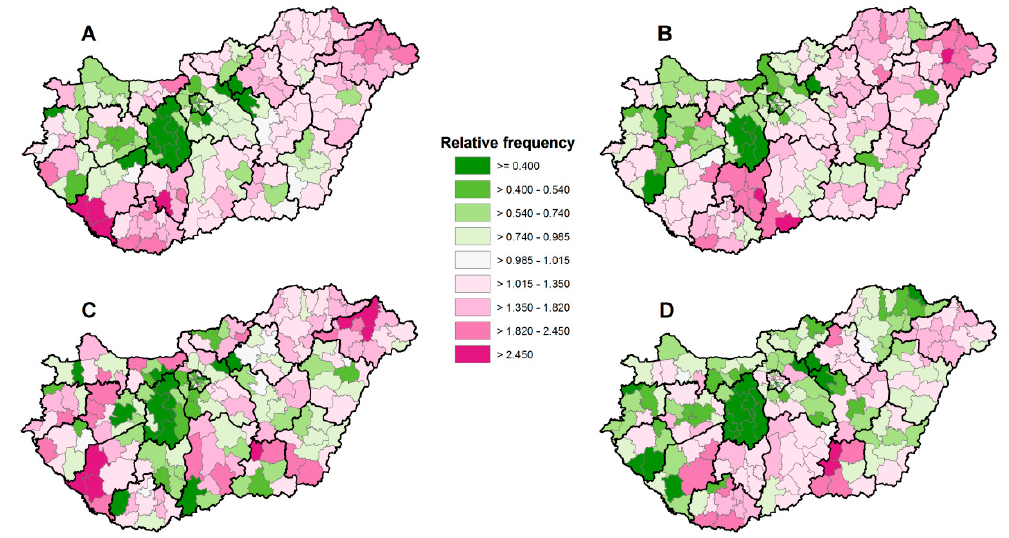
Figure 3. The spatial distribution of the relative frequencies of Clopidogrel ( A ), Syncumar ( B ), Warfarin ( C ), and Xarelto ( D ) redemption at the district level, Hungary, 2016.